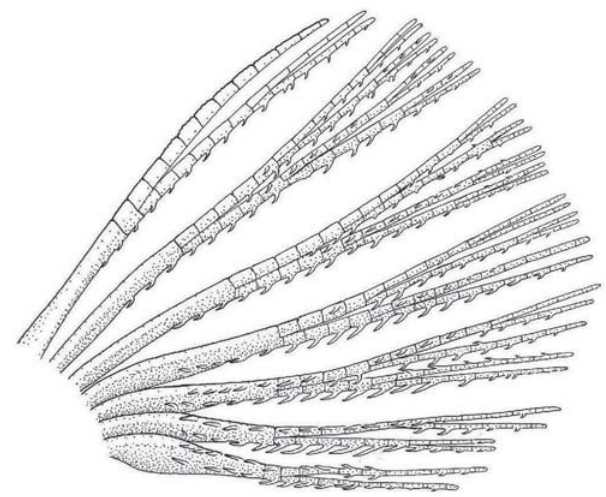
Fig. 40. Mimagoniates barberi , adult male, UMMZ 205420, 32.7 mm SL; pelvic-fin rays, ventral view, left side.